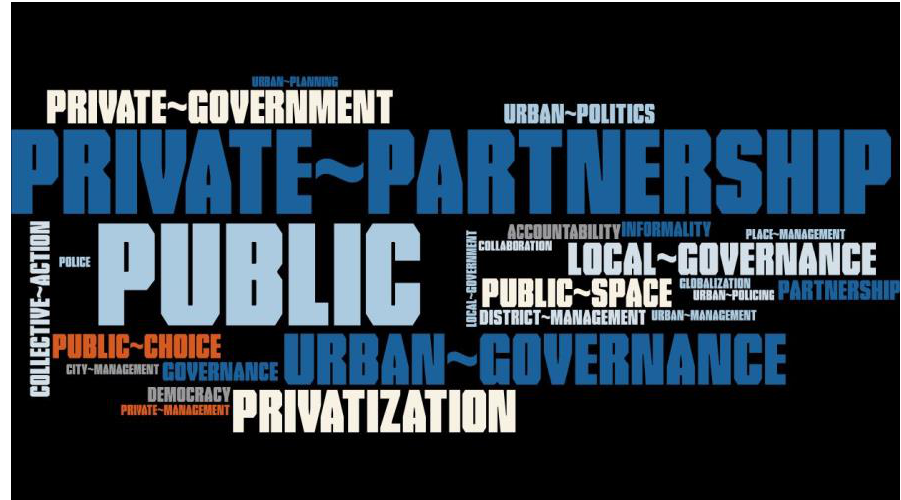
Figure 4. Word cloud extracted from keywords that fit the dimension “Urban Governance”.